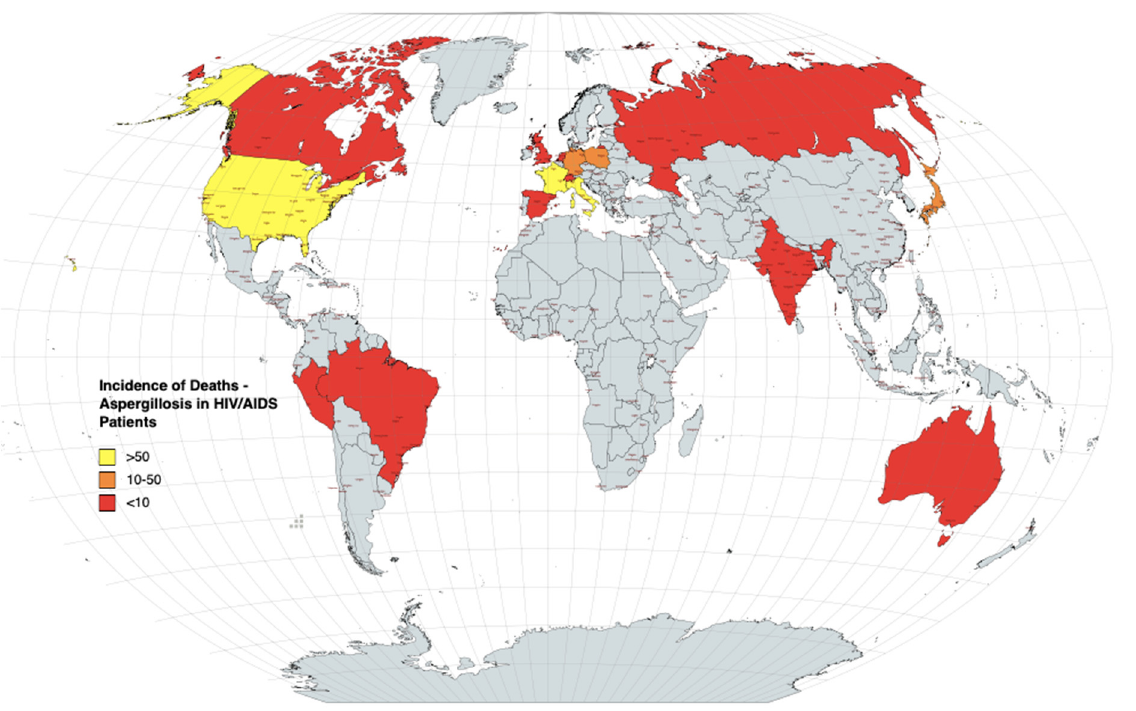
Figure 2. Numbers of deaths linked to aspergillosis in HIV/AIDS patients in publications by country. Categories are >50 patients, 10–50 patients and <10 patients.